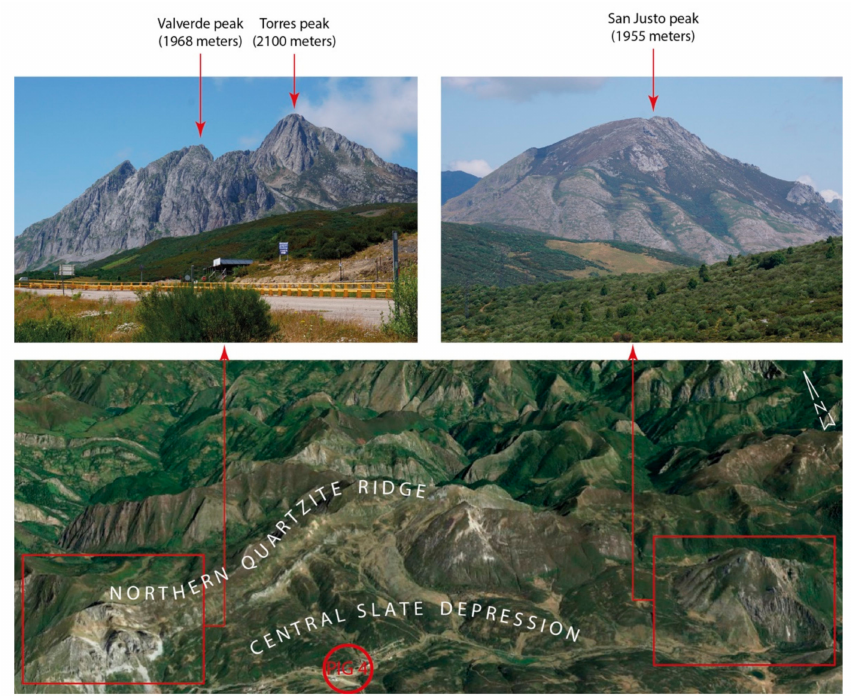
Figure 12. General view (Google Earth image from 2007) of the northern alignment of San Isidro mountain pass and detailed images of Torres Peak (2100 m) and the Valverde range (on the left) and Las Rapa í nas (on the right) in which the absence of relief forms derived from glacial erosion can be seen. Photograph by the authors. Focus with camera on Figure through Onirix site or use the link